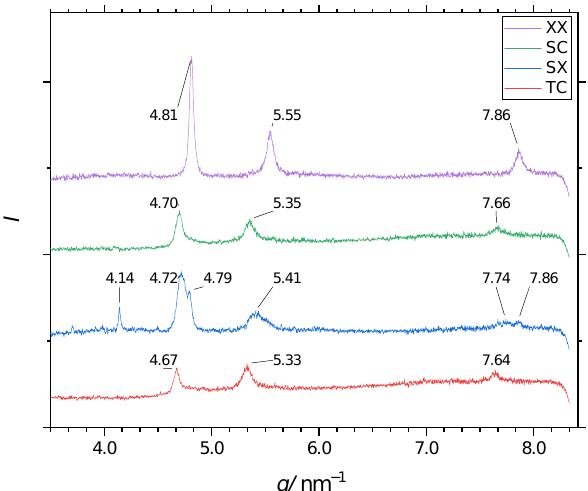
Figure 13. X-ray diffractograms of AISI-316L samples XX , SC (activation S , then carburization C ), SX (activation S , no C ), and TC (activaton T , then carburization C